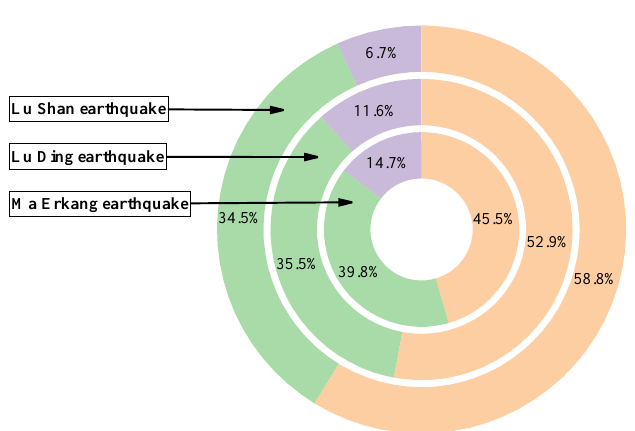
Figure 4. Sichuan earthquake sentiment scale map.